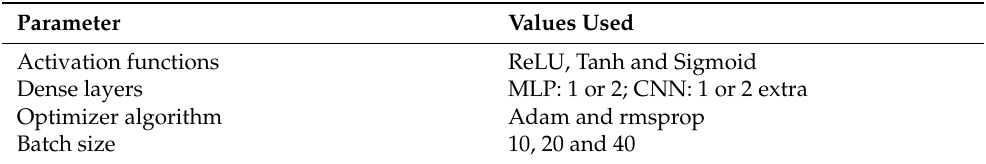
Table 1. Values used for each hyperparameter in this study. Parameter Values Used Activation functions ReLU, Tanh and Sigmoid Dense